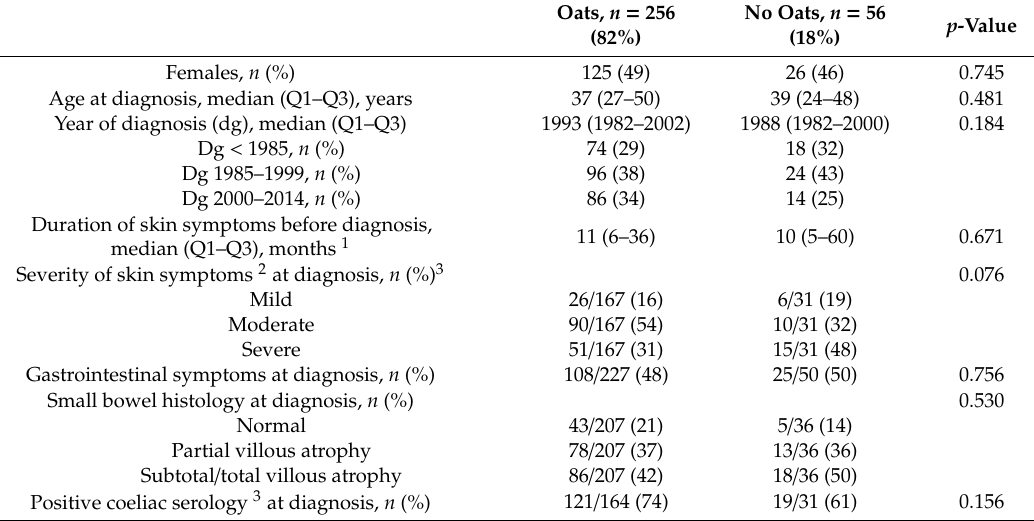
Table 1. Demographic data and clinical, serological and histological findings at diagnosis in 312 dermatitis herpetiformis (DH) patients currently on a gluten-free diet with or without